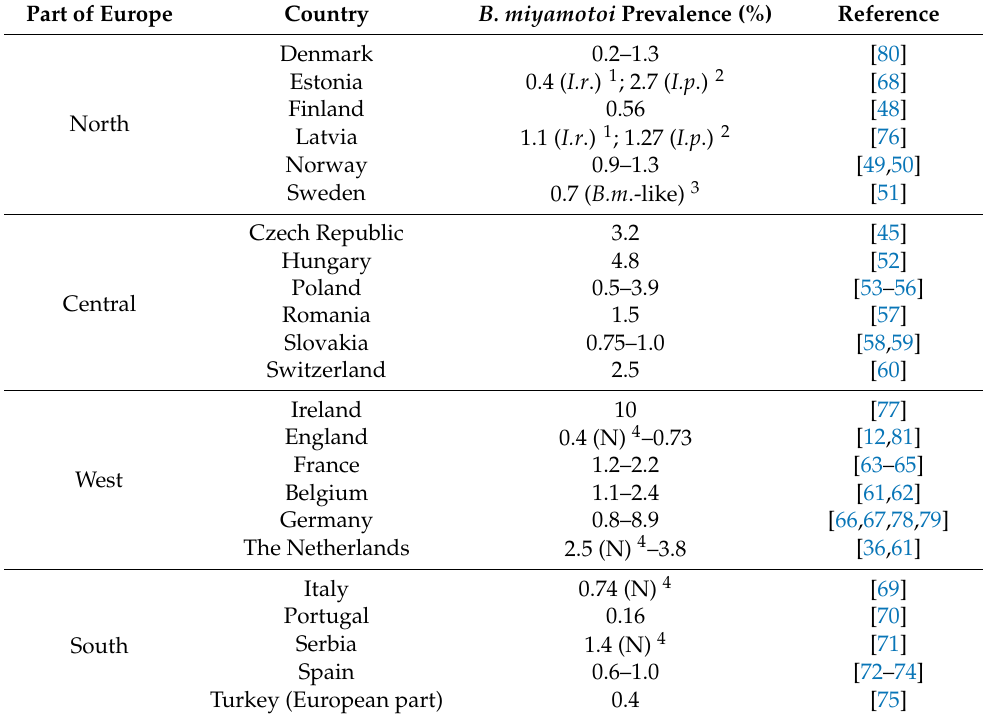
Table 1. Borrelia miyamotoi in host-seeking and feeding Ixodes ricinus and Ixodes persulcatus ticks in